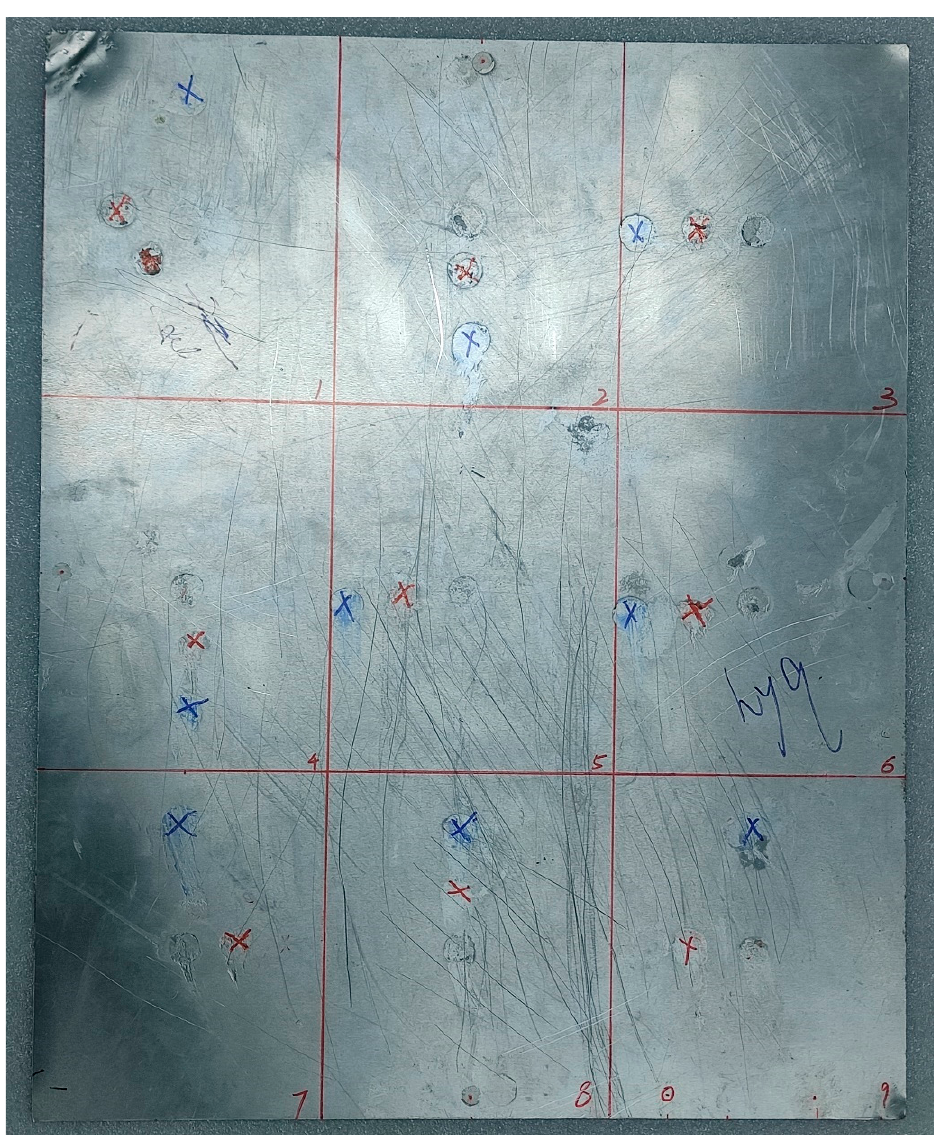
Figure 19. Area division of aluminum plate.